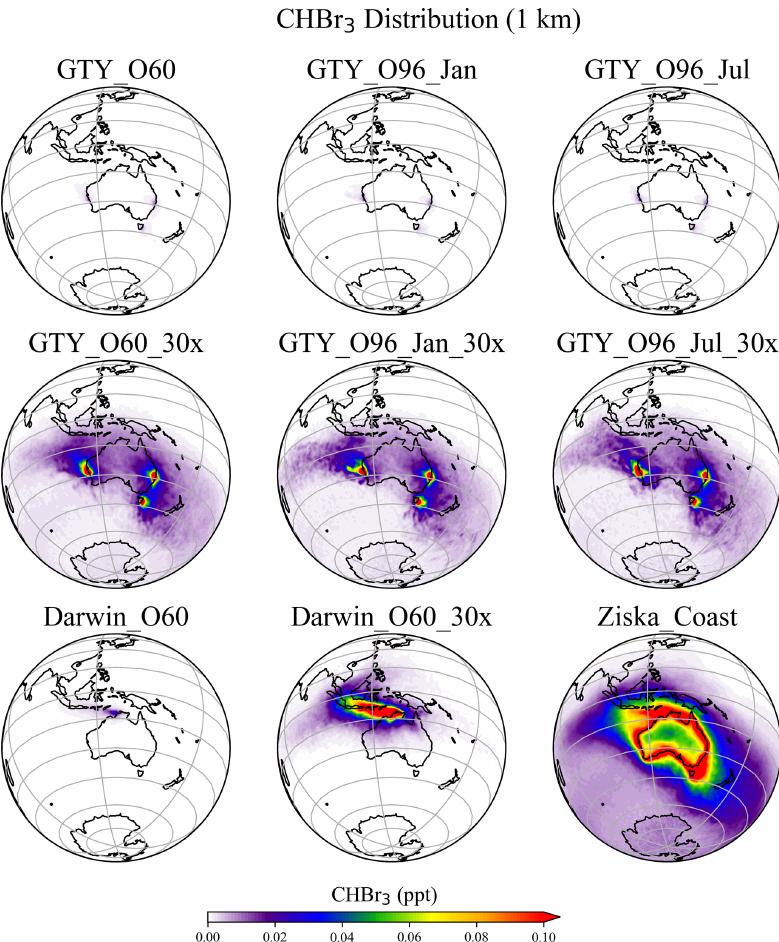
Figure 5. Annual mean CHBr 3 spatial distribution from GTY_O60, GTY_O60_30x, GTY_O96_Jan, GTY_O96_Jan_30x, GTY_O96_Jul, GTY_ O96_Jul_30x, Darwin_O60, Darwin_O60_30x, and Ziska_Coast at 1km